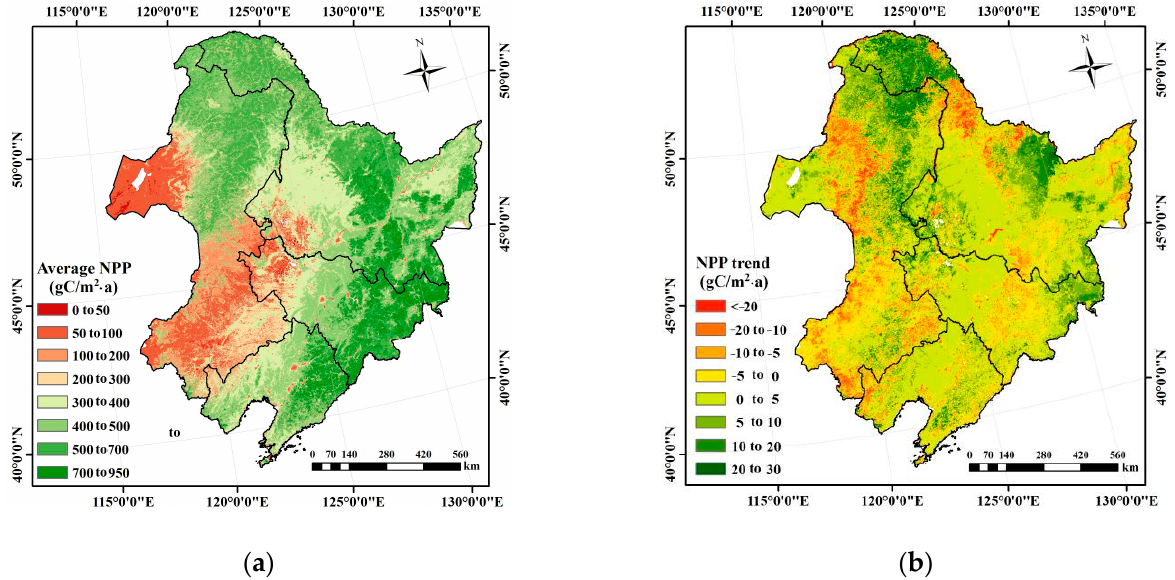
Figure 2. Spatial and temporal variation characteristics of the vegetation NPP in Northeast China: ( a ) spatial distribution of the average NPP over multiple years and ( b ) the NPP trend.